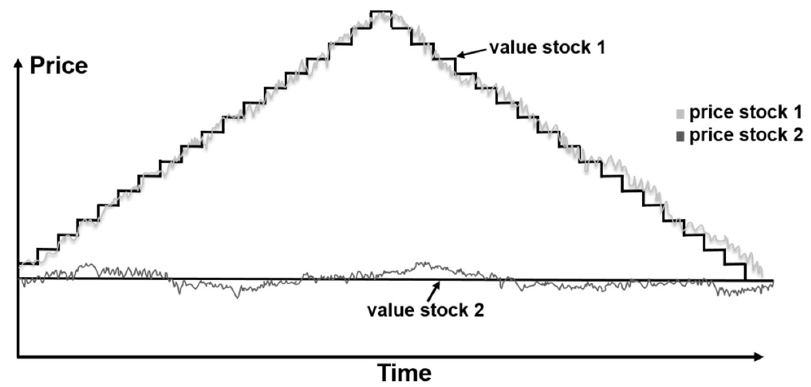
Figure 2. Impact of AT on relation between price and fundamentals.